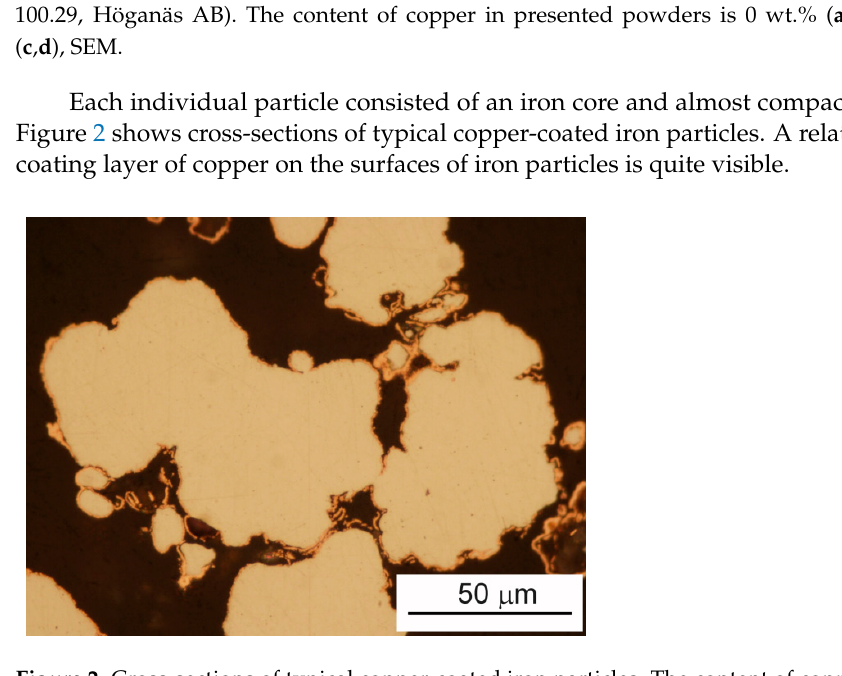
Figure 3. A typical microstructure of compacted copper-coated iron powders. The specimens pre- sented were fabricated by applying a pressure of 600 MPa on copper-coated iron powders contain- ing 3.2 wt.% Cu( a ) and 8.0 wt.% Cu ( b ), nital etched, LM. A typical microstructure of sintered materials is presented in Figures 4 and 5. In Figure 4, the photos of non-etched sintered specimens are presented to demon- strate the evolution of porosity with increasing copper content, from a pure iron (Figure 4a), through to a specimen with 3.2 wt.% Cu (Figure 4b), to a specimen with 8 wt.% Cu (Figure 4c). As the content of copper was increased, the size of pores also visibly increased. Figure 4. Pores in sintered materials: ( a ) Fe, ( b ) Fe-3.2 wt.% Cu, and ( c ) Fe-8.0 wt.% Cu, LM. In Figure 5, chemically treated cross sections of sintered specimens with 3.2 wt.% Cu (Figure 5a) and 8 wt.% Cu (Figure 5b) are presented. The specimens were etched with nital